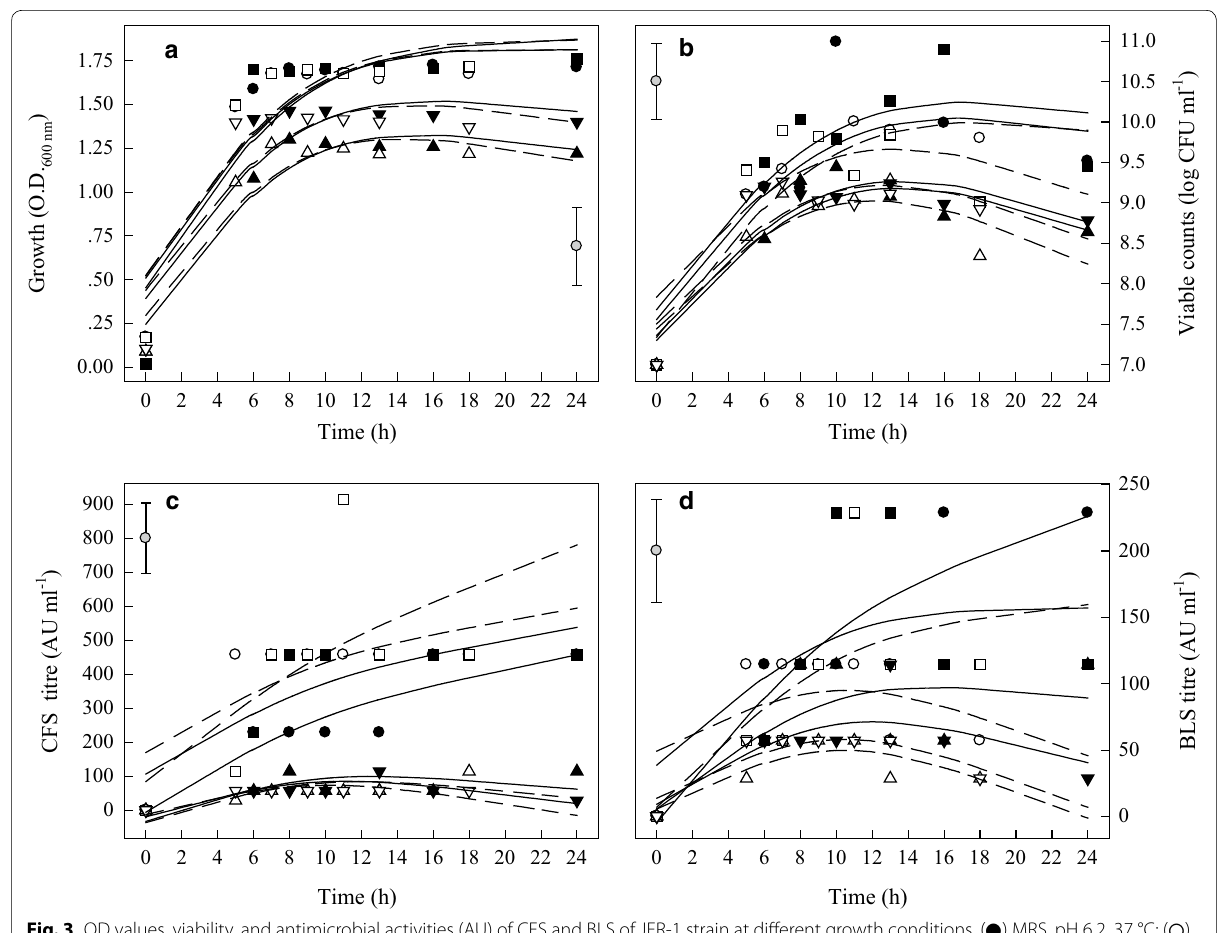
Fig. 3 OD values, viability, and antimicrobial activities (AU) of CFS and BLS of JFR-1 strain at different growth conditions. ( ● ) MRS, pH 6.2, 37 °C; ( ○ ) MRS, pH 6.2, 44 °C; ( ■ ) MRS, pH 7.4, 37 °C; ( □ ) MRS, pH 7.4, 44 °C; ( ▲ ) BHI, pH 5.5, 37 °C; ( △ ) BHI, pH 5.5, 44 °C; ( ▼ ) BHI, pH 6.2, 37 °C; ( ▽ ) BHI, pH 6.2, 44 °C. a Optical density (OD); b LAB viable counts; c antimicrobial activity of CFS and d antimicrobial activity of BLS. The experimental data were fitted to the logistic model. The vertical bar represents standard errors of the